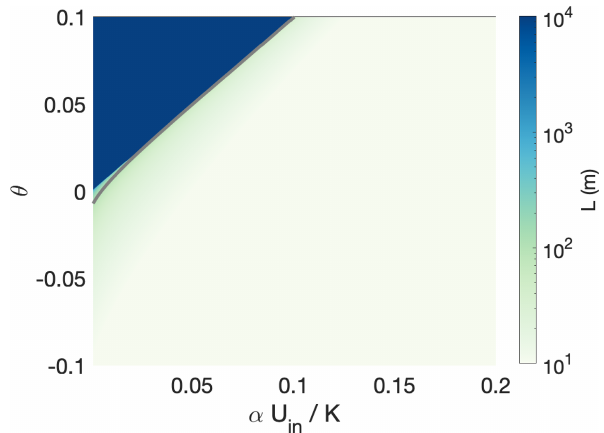
Figure 4. Seawater intrusion distance through a soft bed, calculated numerically from Eq. (19) over a range of bed slopes and αU in /K (a dimensionless parameter indicating the relative strength of fresh- water discharge to hydraulic conductivity). Gray contour indicates 100m seawater intrusion